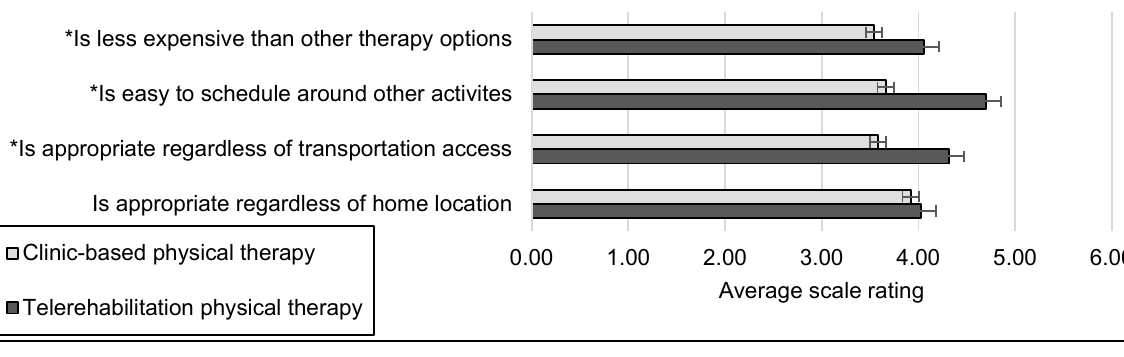
Note . Error bars represent the standard error of mean. * indicates significant difference between the two service delivery models given p <